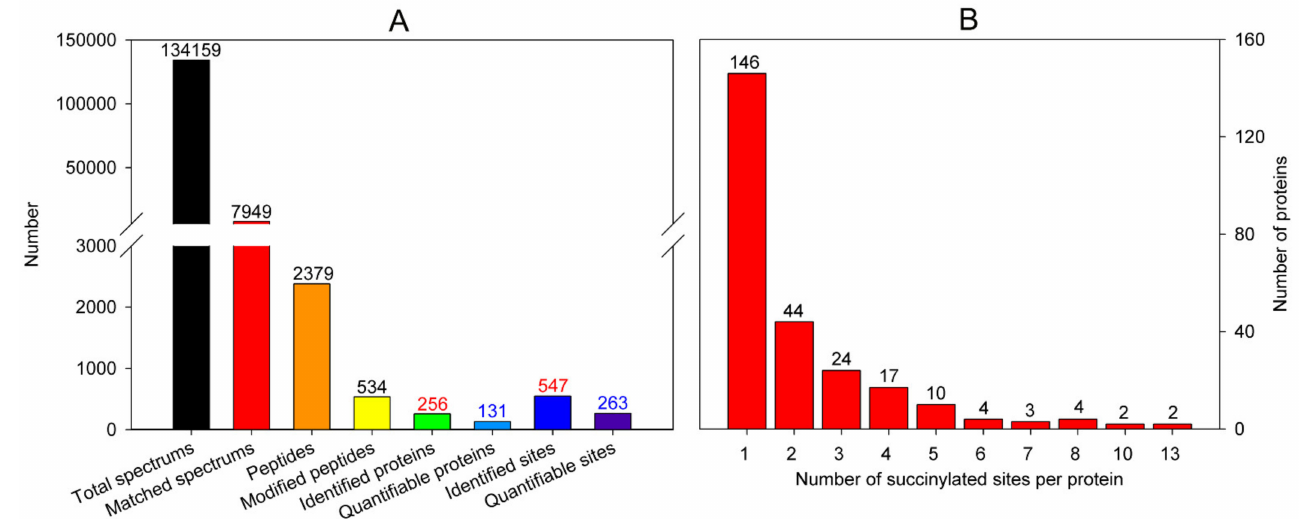
Figure 2. Statistics of basic LC–MS/MS data ( A ) and identified proteins with different numbers of succinylated sites ( B ) in the shoots of turnip